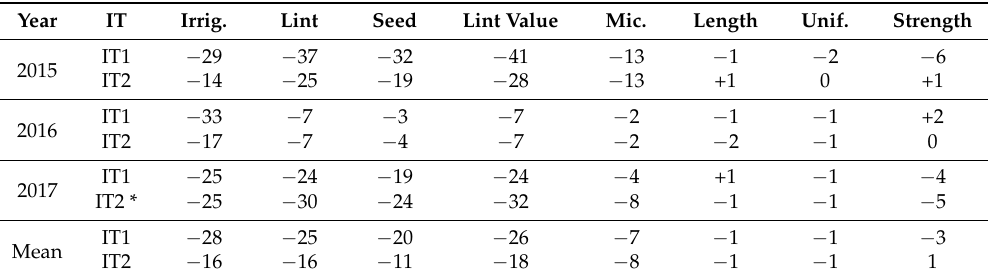
Table 10. Percent changes in irrigation amount, lint and seed yields, lint value, and fiber quality relative to the IT3